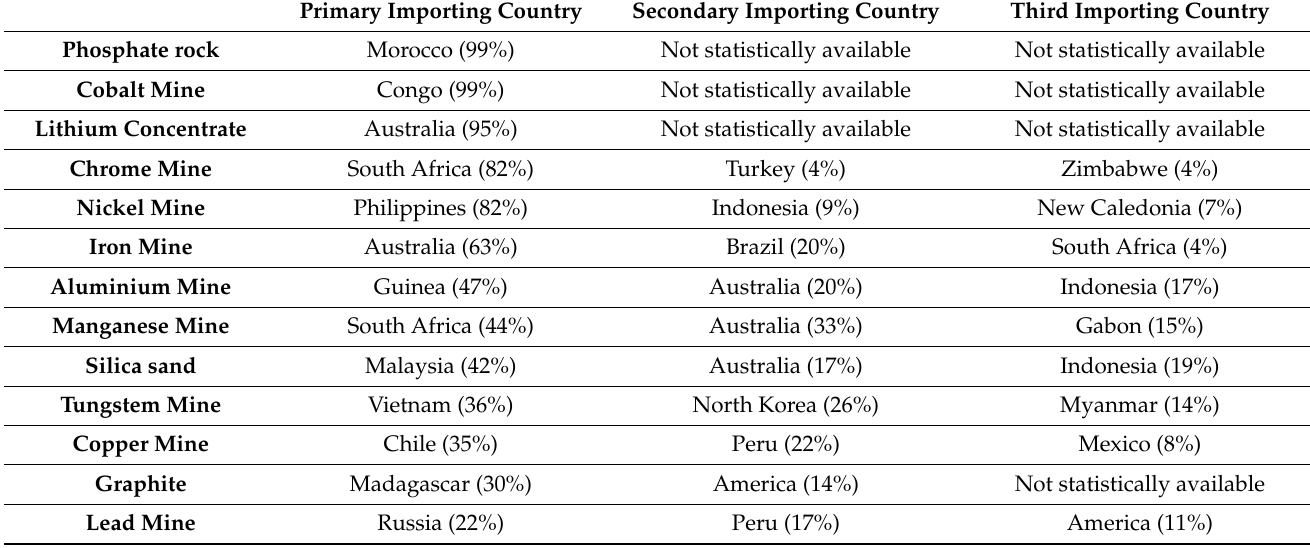
Table 3. Proportion of China’s primary mineral resource import sources in 2020 (Data Source: [29]). Primary Importing Country Secondary Importing Country Third Importing